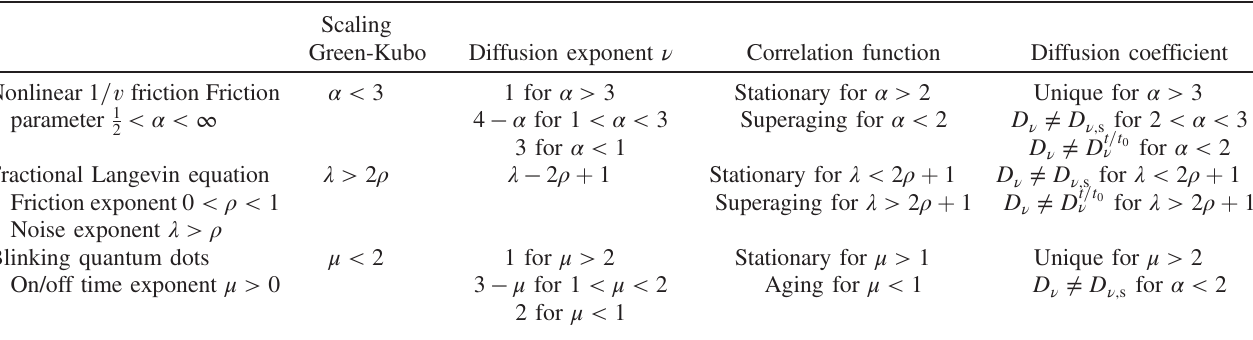
TABLE I. Summary of the aging and diffusive properties for the three systems discussed in Secs. III A, III B and III C. The first column lists the system and the relevant parameters. The second column states the parameter range in which the scaling Green-Kubo relation is applicable; the resulting diffusion exponent is given in the third column. The aging properties of the correlation function are given in the fourth column. The fifth column states whether the diffusion coefficient depends on the initial condition and, if so, whether it explicitly depends on the aging time t 0